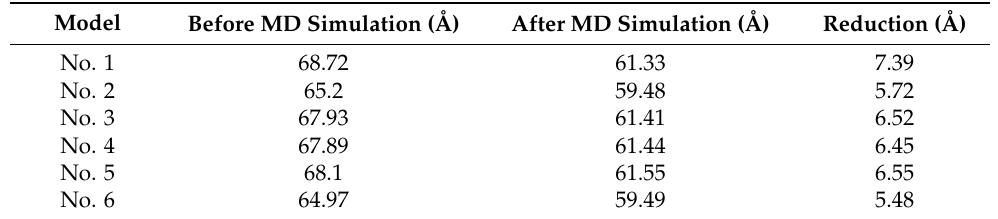
Table 2. Cell lengths in the Z direction.